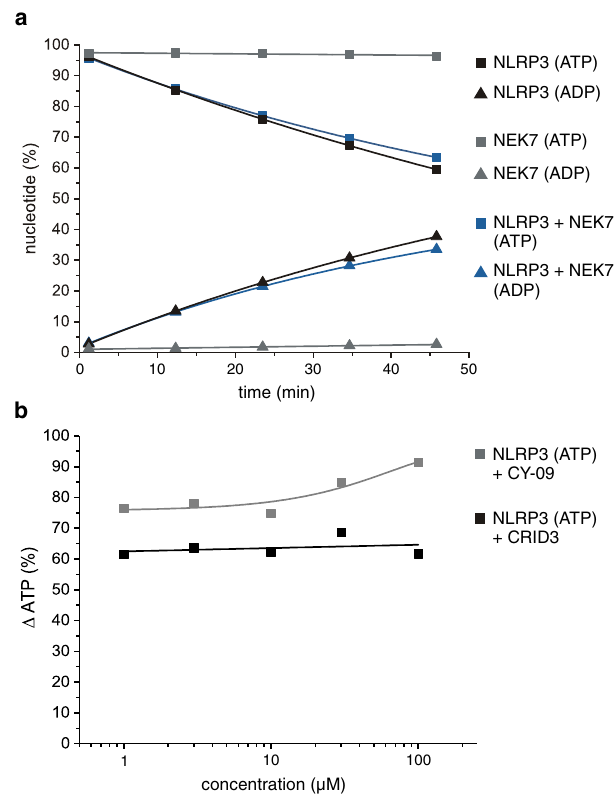
Fig. 6 Effects of NEK7 and antagonists CRID3 (MCC950) or CY-09 on the ATP-hydrolysis activity of NLRP3. a The hydrolysis activity of MBP- NLRP3 peak 1 is unaffected by NEK7. MBP-NLRP3 peak 1 (3 µ M) was incubated with NEK7 at 25 °C for 60 min in the presence of 100 µ M ATP. The amount of ADP and ATP (%) is shown for MBP-NLRP3 peak 1 alone and addition of NEK7 to MBP-NLRP3. As a control, the kinase NEK7 exhibits no residual ATPase activity in the absence of substrate (gray symbols). b The hydrolysis activity of MBP-NLRP3 peak 1 is unchanged by CRID3 (MCC950) or CY-09. MBP-NLRP3 peak 1 (3 µ M) was incubated at 25 °C for 60 min in the presence of 100 µ M ATP. Increasing concentrations of CRID3 or CY-09 were added in a dose-response measurement from 1 to 100 µ M and the relative concentration of ATP after 60 min